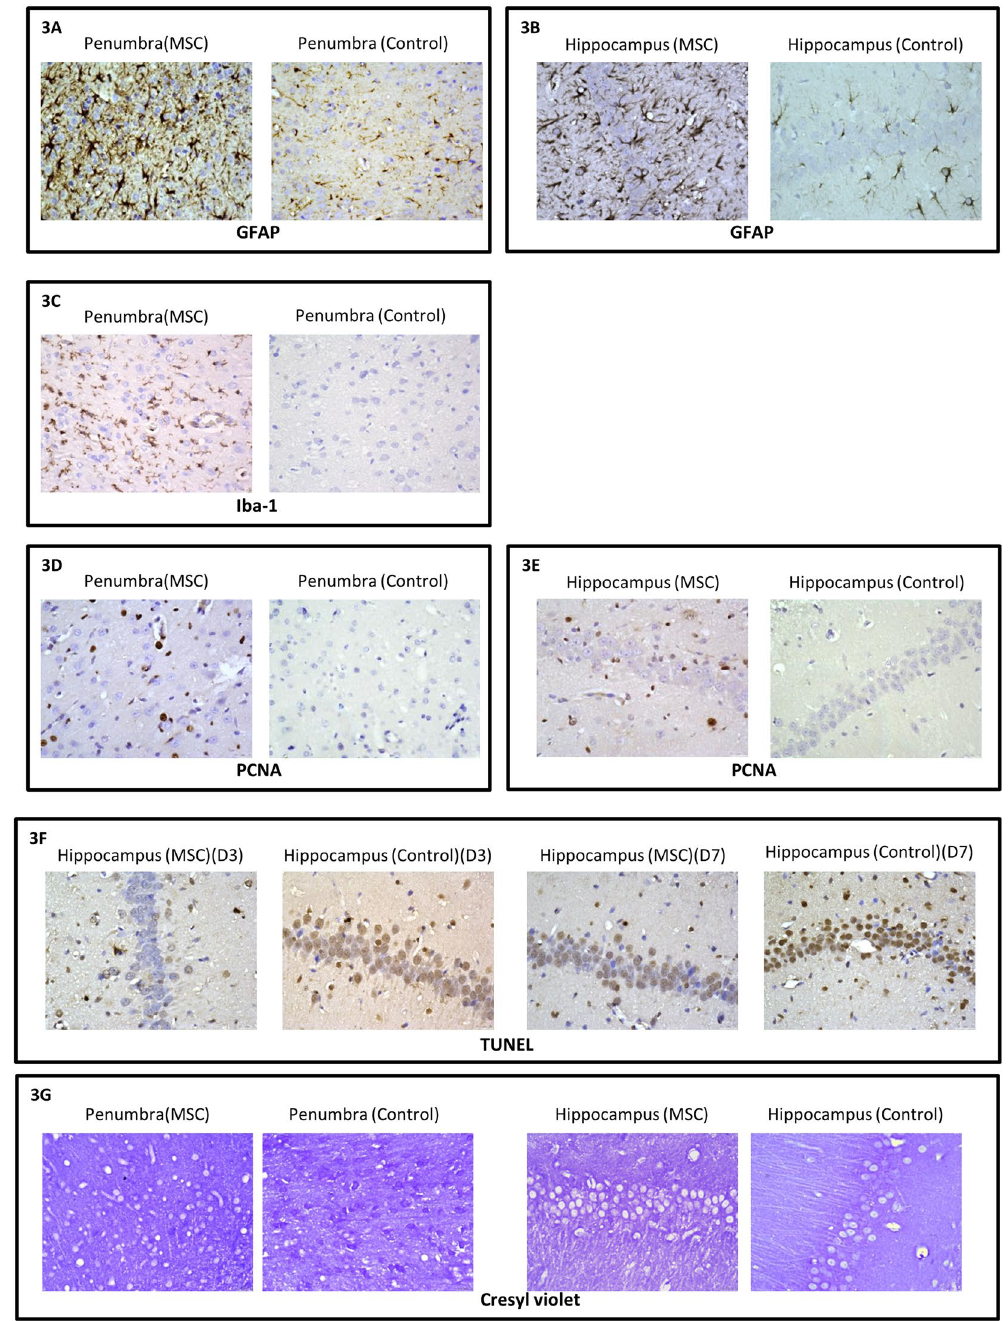
Figure 3. Representative photos of histochemical staining images at different time points post-MSC treatment. At day 3, MSC-treatment group had more GFAP + ve cells in the TBI penumbra ( 3A , IHC x400) and hippocampus ( 3B IHC x400). More Iba-1 + ve cells ( 3C HIC x400) were observed in the penumbra of MSC- treatment group. Both the penumbra ( 3D IHC x400) and hippocampus ( 3D IHC x400) also had higher PCNA expression. MSCs attenuated apoptosis in the hippocampus ( 3F Tunel, x400). At day 14, more neurons were found in both penumbra and hippocampus of MSC-treatment group ( 3G Cresyl Violet